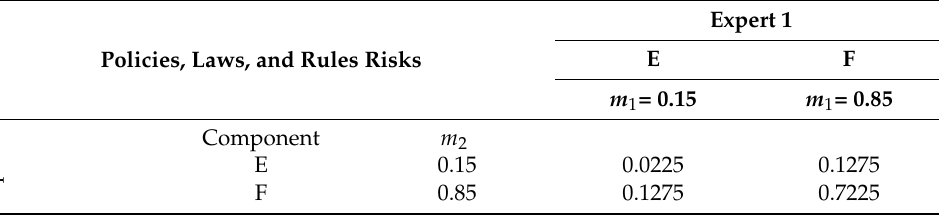
Table 9. Dempster combination of Expert 1 and Expert 2 for policies, laws, and rules